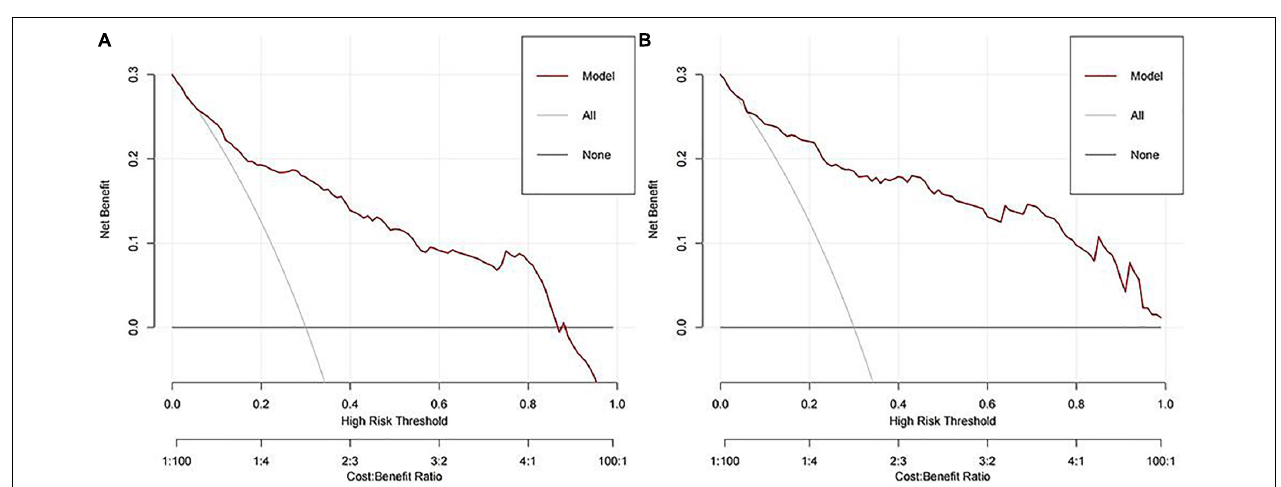
FIGURE 2 | Calibration curves for predicting the onset of intestinal metaplasia and dysplasia in chronic atrophic gastritis (CAG) patients. (A) Training cohort. (B) Validation cohort.